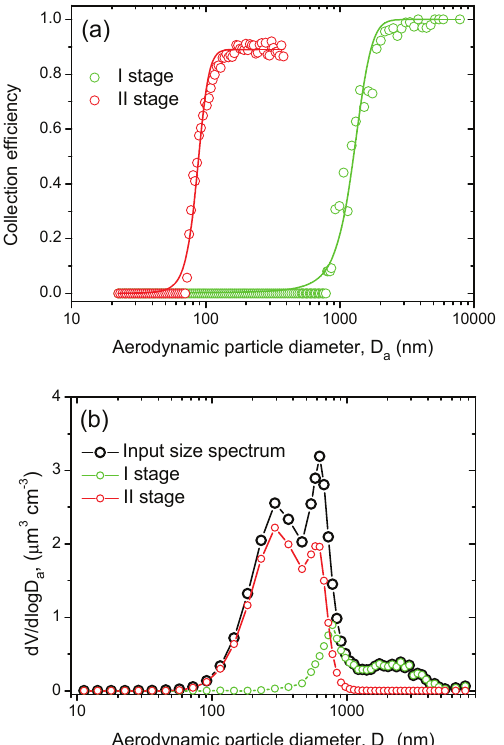
Figure 2. (a) Particle collection efficiency and (b) average vol- ume distribution of the atmospheric aerosol particles deposited on the impactor stages of the MOUDI impactor. The collection ef- ficiency data were fitted using a Boltzmann sigmoidal algorithm (solid